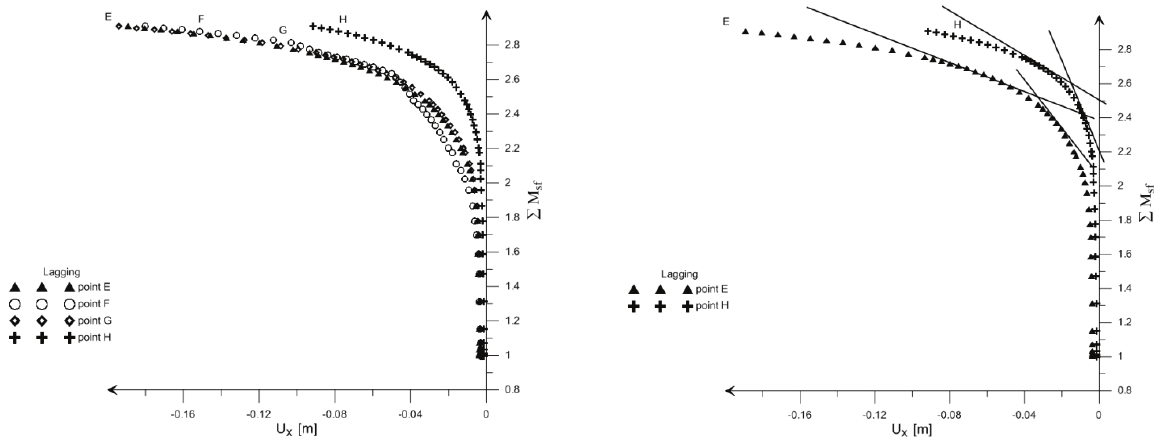
Fig. 17. Determining safety factor for measurement points in lagging (excavation depth 4